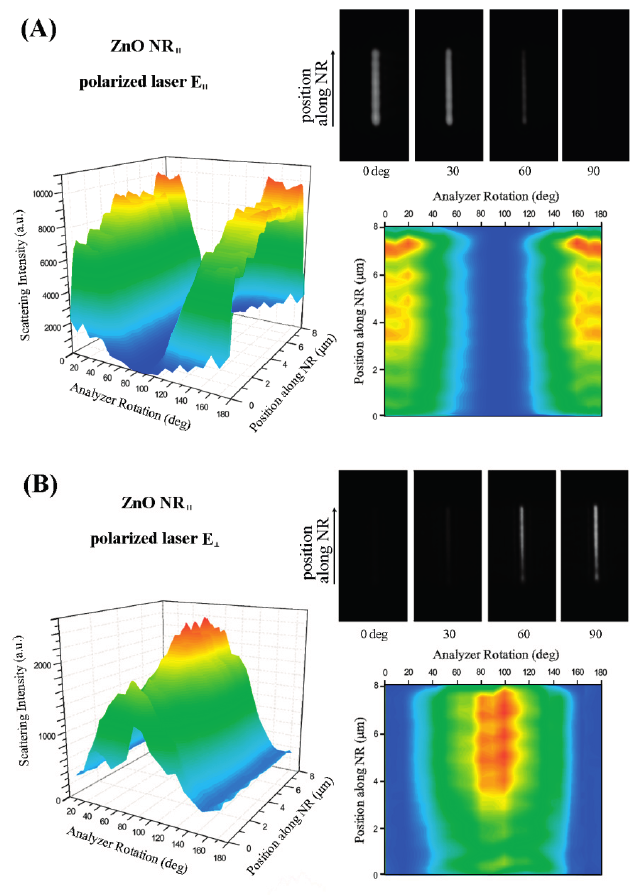
Figure 2. Scattering of a single ZnO NR (138 nm in diameter, 8.06 μ m in length) measured by using two polarization directions of an incoming laser ( E ║ and E ┴ ) on the NR oriented in the y direction (ZnO NR ║ ) . Scattering intensity is measured with respect to the position along the length of the 1D nanomaterial as well as the analyzer angle. ( A ) The 3D contour plot summarizes scattering results from a ZnO NR ║ under the excitation of E ║ as a function of both the analyzer angle and the spatial position on the NR. The highest and lowest scattering is observed when the collection polarization angle is set parallel (0°) and perpendicular (90°) to the incoming polarization direction, respectively. The phenomenon is clearly seen in the 2D projection of the scattering intensity with respect to the analyzer angle at each position along the length of the ZnO NR ║ . Color schemes used in the 2D plot are the same as the scattering intensity level profiled in the 3D contour graph. A series of grey-scale panels are the scattering images obtained from the ZnO NR measured at the analyzer angle of 0°, 30°, 60°, and 90°, presented from left to right, respectively. ( B ) The same set of scattering measurements was repeated by using the orthogonal excitation of E ┴ as functions of the analyzer angle and the spatial position on the same ZnO NR ║ shown in (A). Similar to what was observed under E ║ , highest and lowest scattering from the NR occurred when the analyzer angle was set parallel and perpendicular to E ┴ , respectively. In (B), those analyzer angles correspond to 90° for the former and 0° for the latter